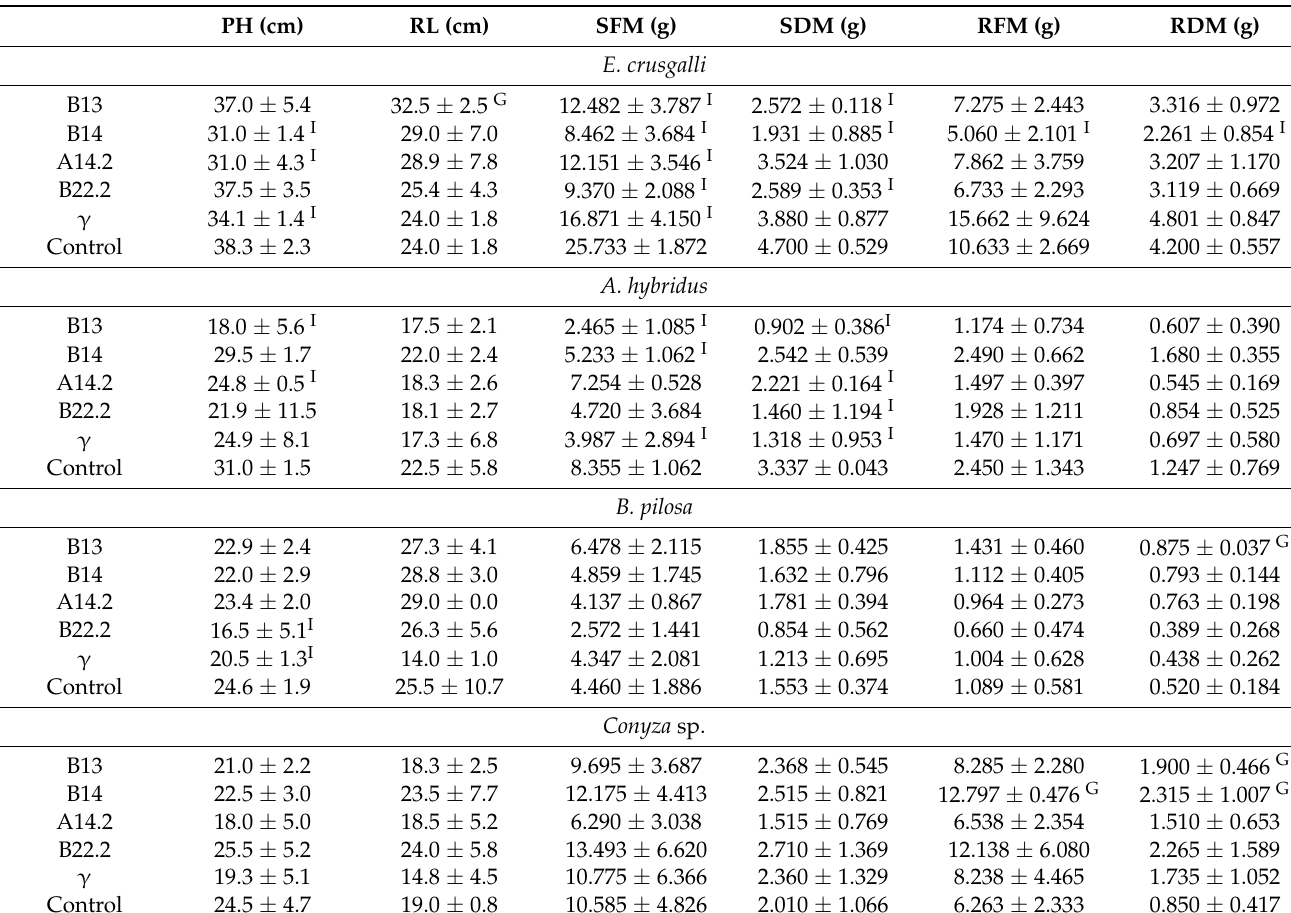
Table 2. Phytotoxic effects of microorganism metabolites on Conyza sp., B. pilosa , A. hybridus , and E. crusgalli plants after 21 days after application